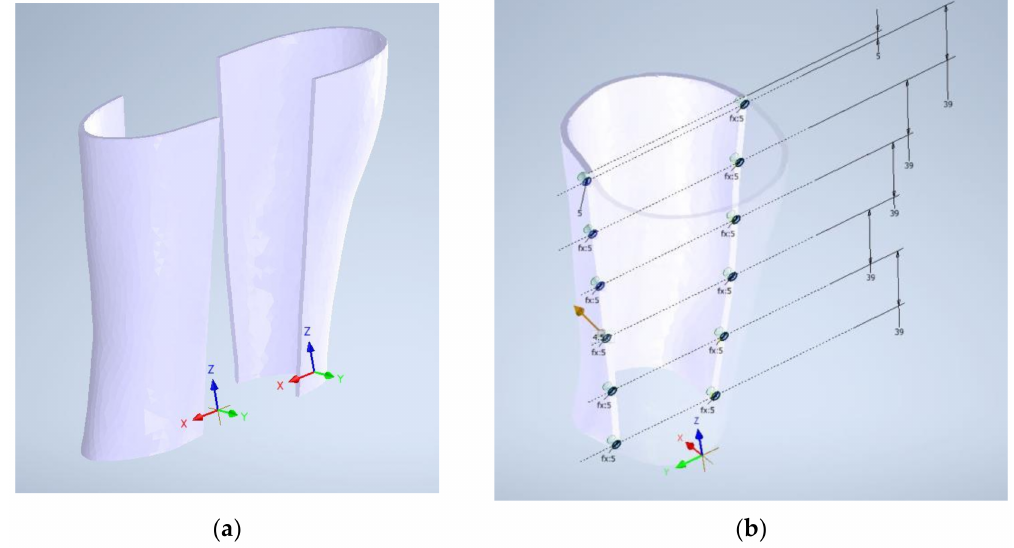
Figure 8. Division of the splint ( a ) and magnet housing design ( b